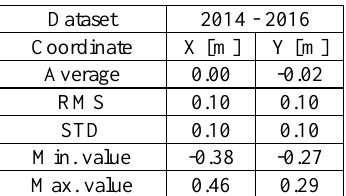
Table 5. Consistency of planimetric coordinate measurements